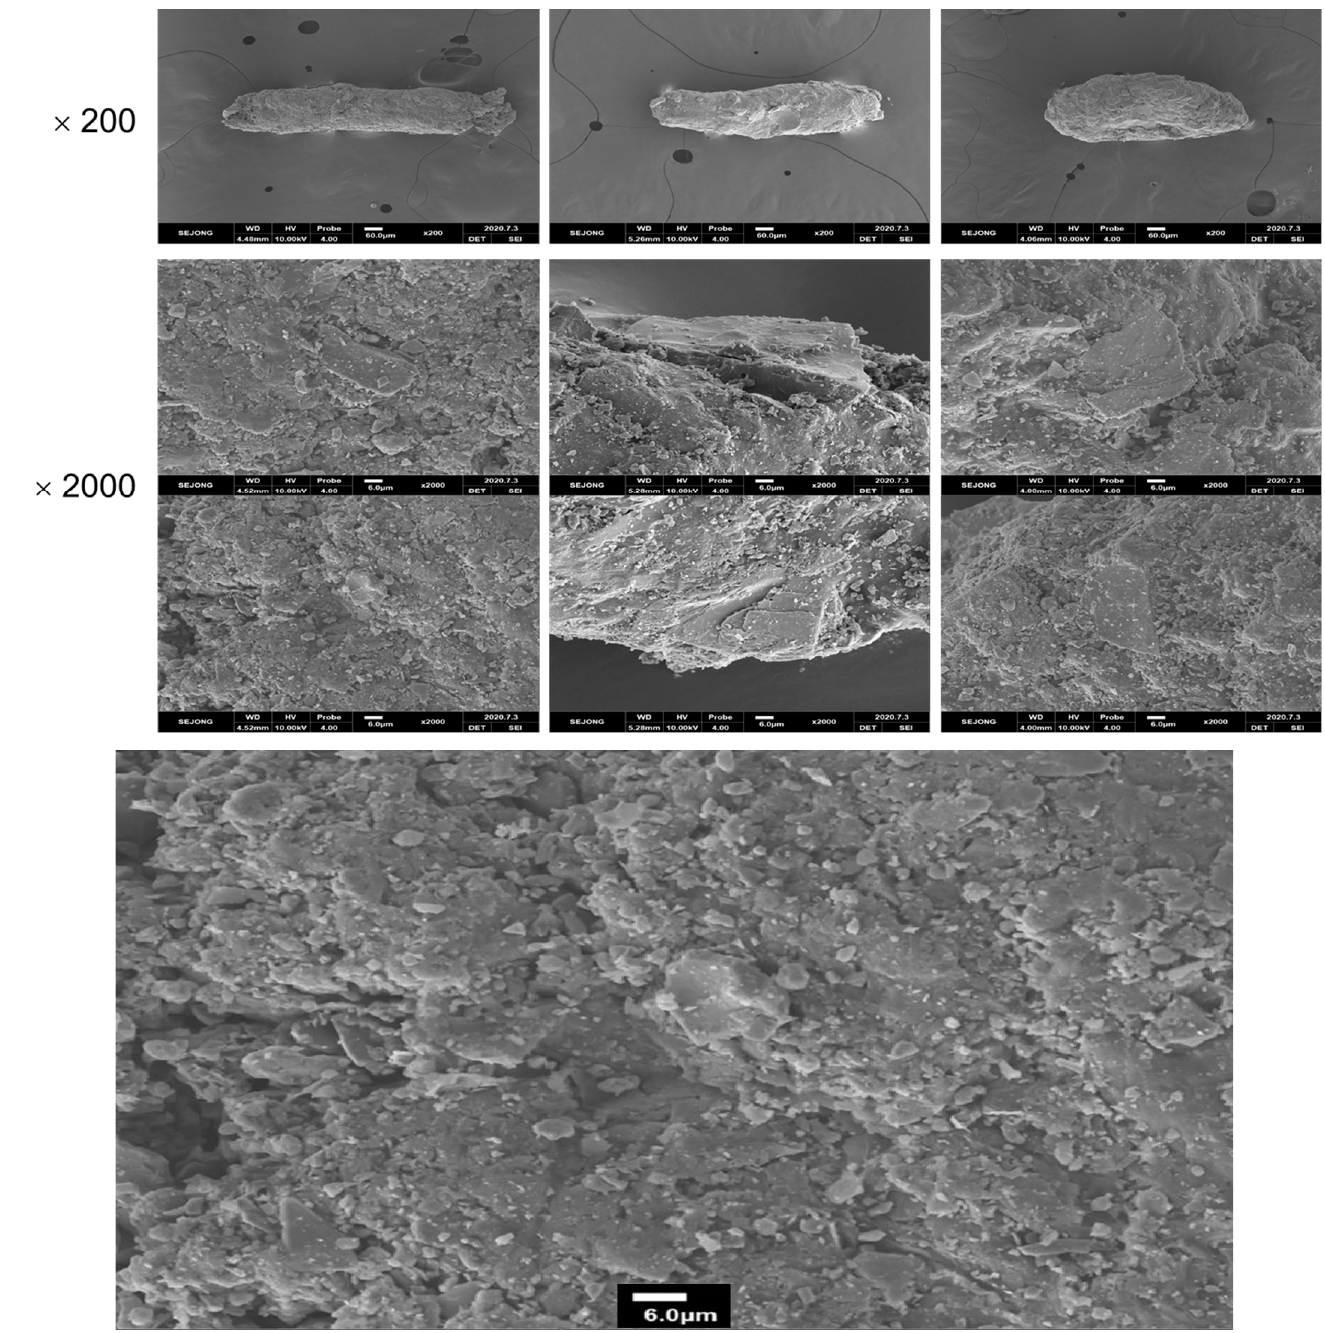
Figure 2. SEM images of the real TRWPs of 212 – 500 μ m collected at a bus stop. The scale bars are 60 and 6 μ m for the magnifications of 200 and 2000, respectively.